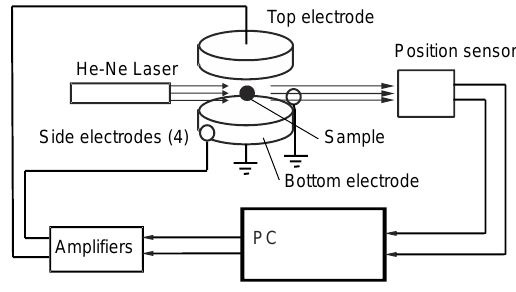
Figure 10. Conceptual drawing of electrostatic levitation method.